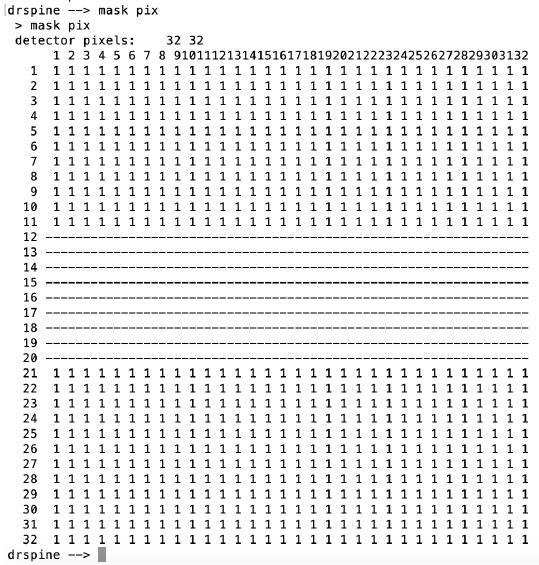
Figure 1. Detector mask applied for the lamellar phase. All pixels marked with 1 are excluded from the evaluation. In this representation the main direction of Q -variation is